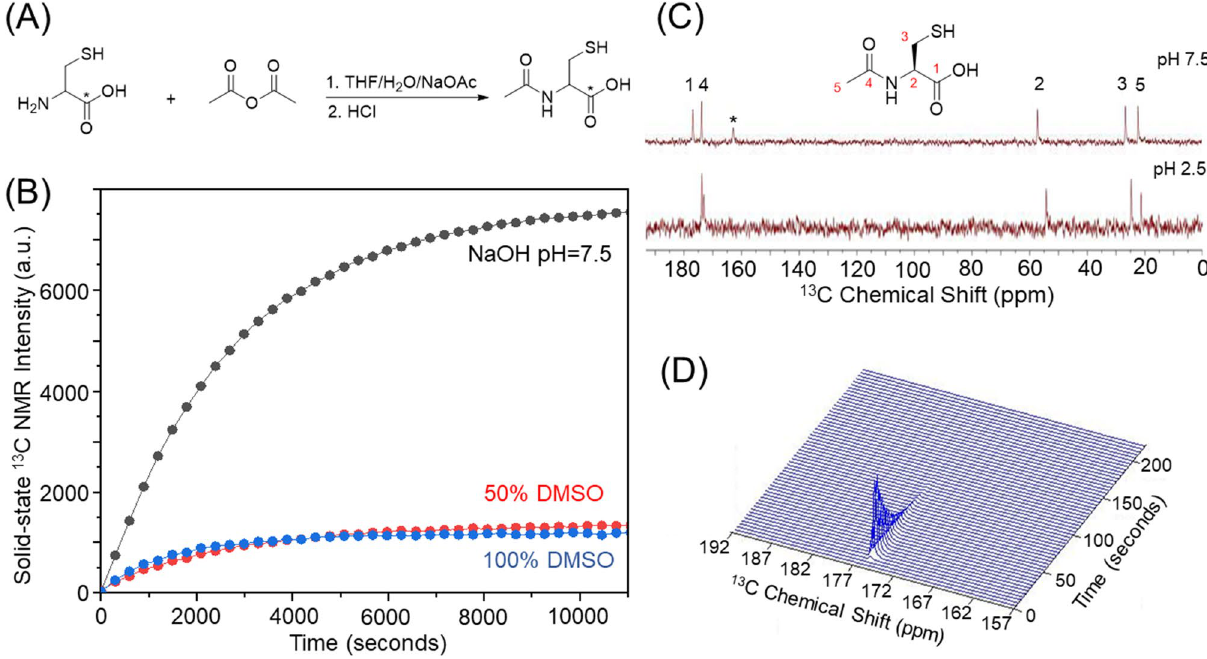
Figure 1. Optimizing sample conditions for hyperpolarized in vivo NMR/MRI experiments with N -acetyl cysteine. ( A ) Synthetic scheme of [1- 13 C] NAC. ( B ) Hyperpolarization build-up curves of [1- 13 C] NAC showing the drastic improvement of polarization using the optimized condition of a NaOH solution vs DMSO solutions. ( C ) 13 C NMR spectra of unlabeled NAC at 1 T NMR confirm the pH dependence of polarization. An asterisk (*) is from a referencing standard of 13 C Urea. ( D ) Dynamic spectra of hyperpolarized [1- 13 C] NAC in PBS buffer at 3 T MRI indicates a T 1 relaxation time of 19.6